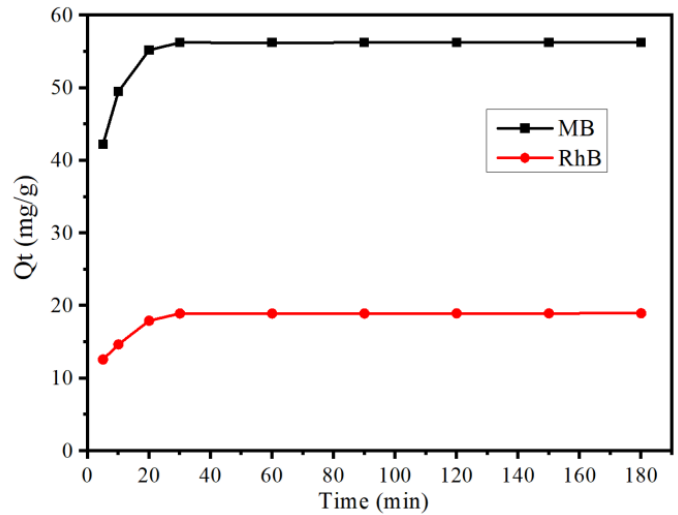
Figure 5. Adsorption kinetics curves of B-TiO 2 /C 4 on MB and RhB.